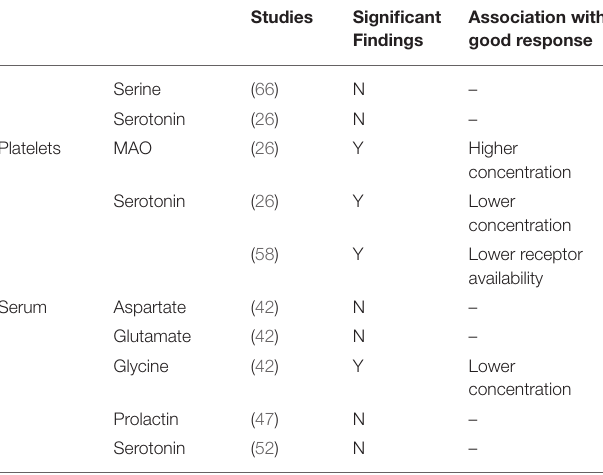
TABLE 5 | Results from CSF and blood-based